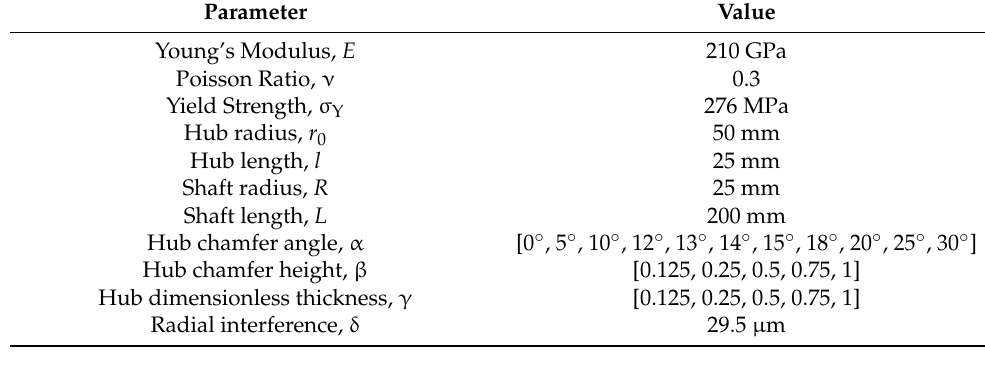
Table 1. Parameters used in the finite element simulations.